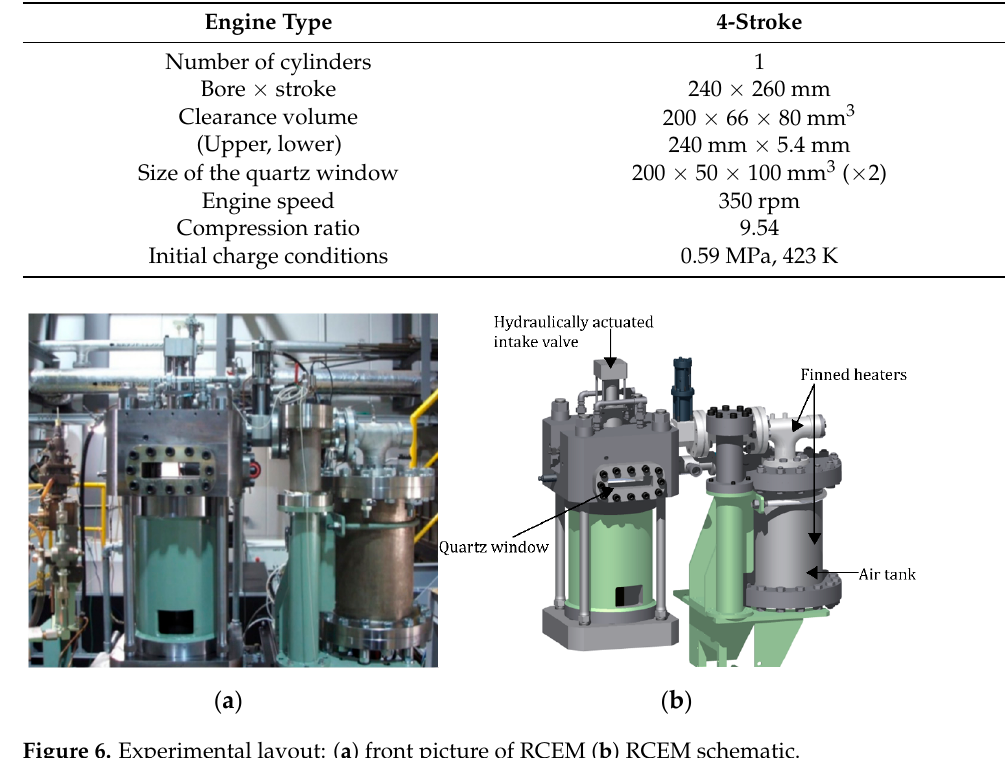
Figure 6. Experimental layout: ( a ) front picture of RCEM ( b ) RCEM schematic.